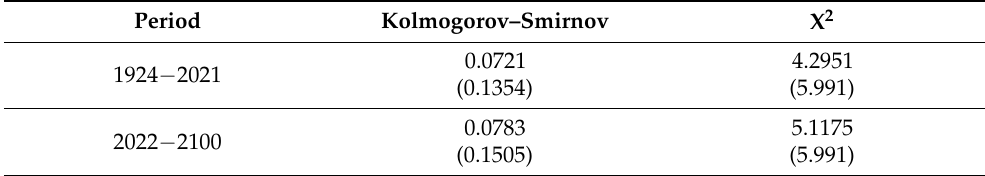
Table 5. Results of the statistical tests (Chi-square and Kolmogorov − Smirnov tests) of the Gener- alized Extreme Value distribution fitting to the annual maximum daily runoff time series of the Fluminimaggiore basin for the past (1924–2021) and the future climate scenario (2022–2100), pre- dicted using HadGEM2-AO data in the RCP 85 configuration. Statistics of the Chi-square and Kolmogorov − Smirnov tests for normality, applied to the series, have 5% significance level.